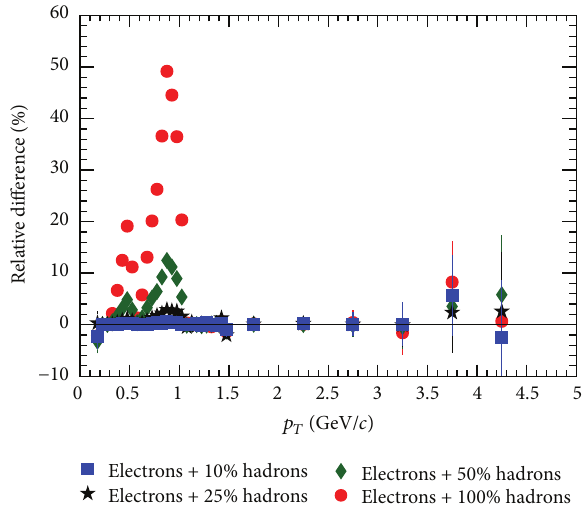
Figure 9: Relative difference Δ between observed yield and signal in a pure electron sample (bias due to hadron contamination) as a function of electron 𝑝 𝑇 for various hadron misidentification